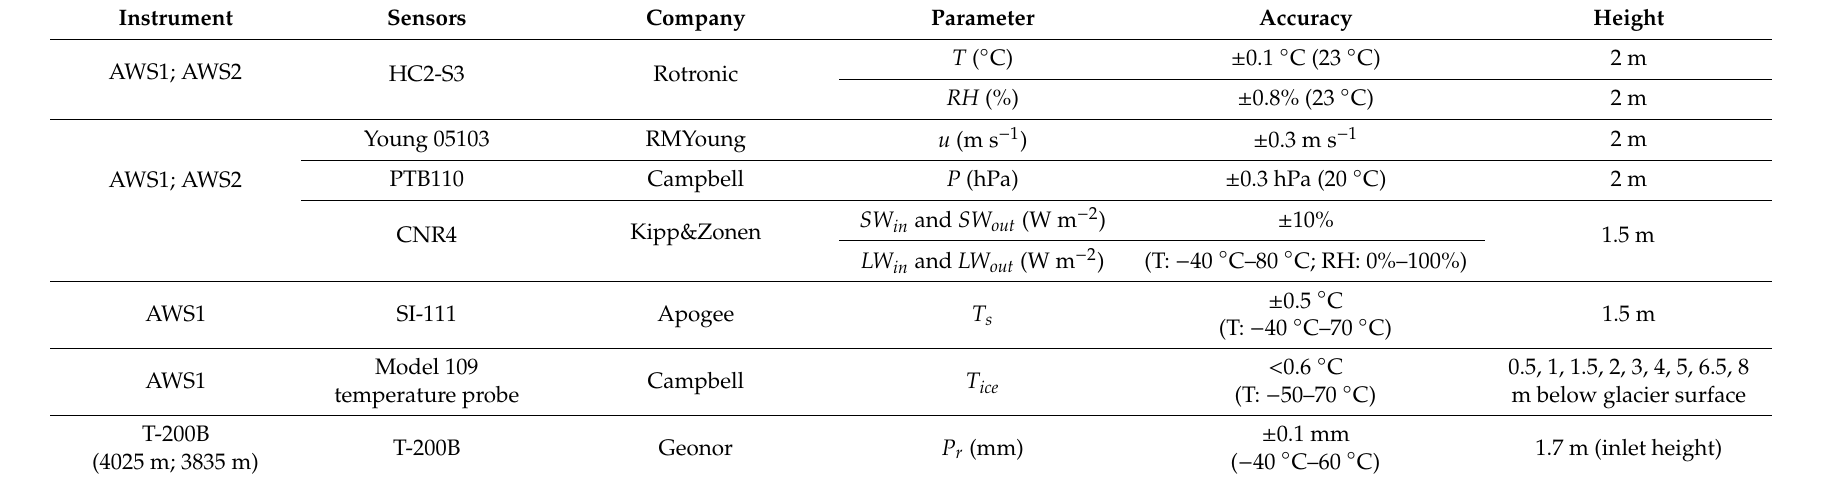
Table 1. Information and parameters of AWSs sensors and precipitation gauges used in this